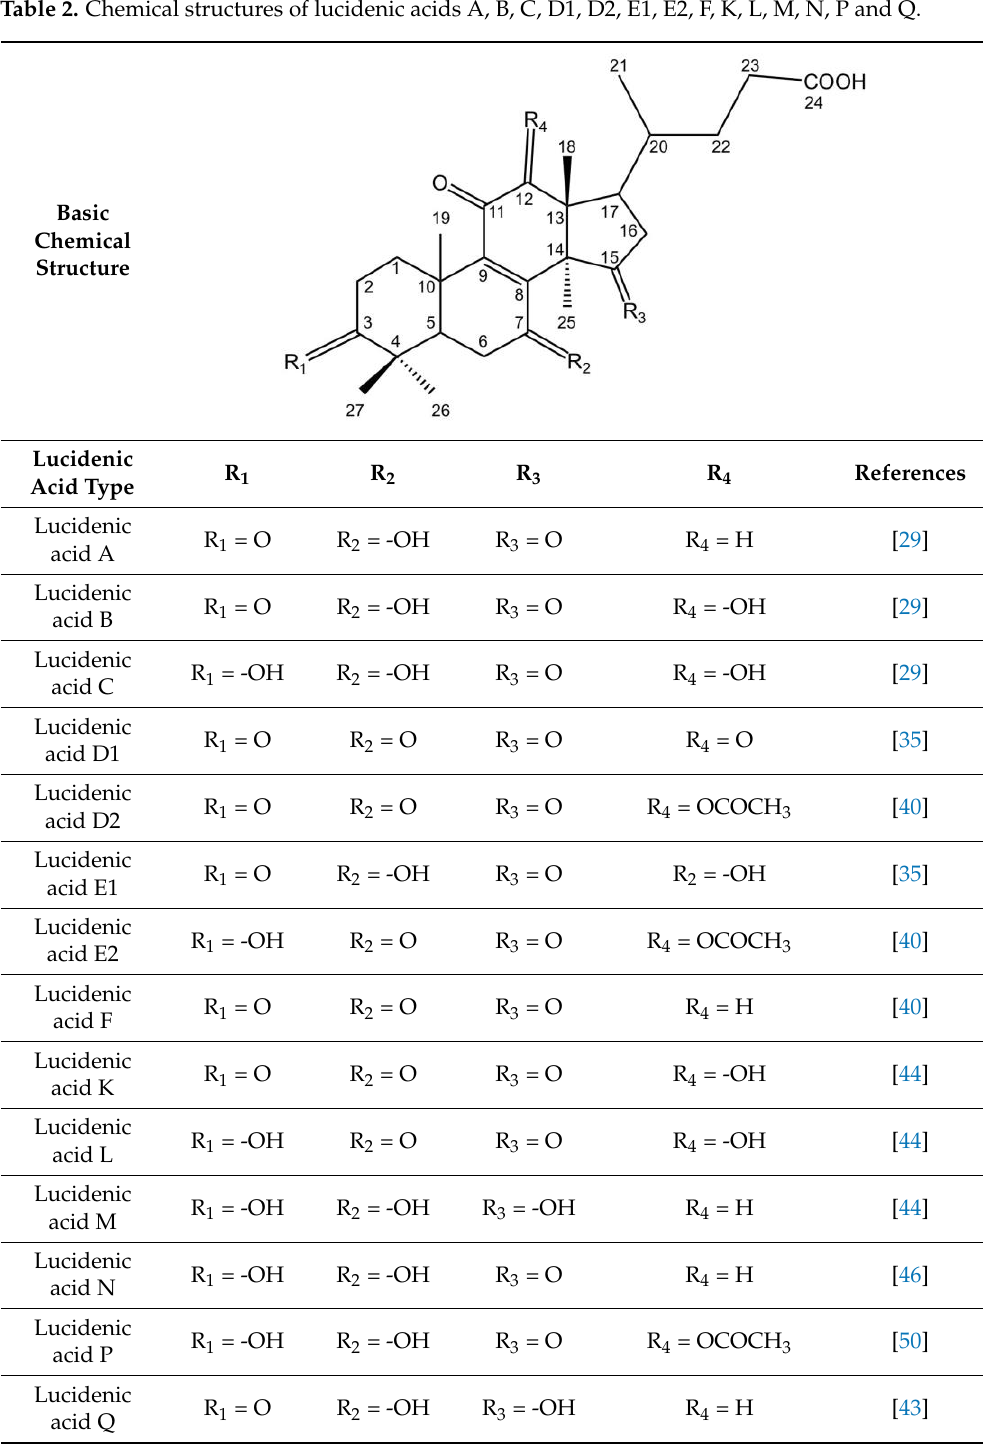
Table 2. Chemical structures of lucidenic acids A, B, C, D1, D2, E1, E2, F, K, L, M, N, P and Q.